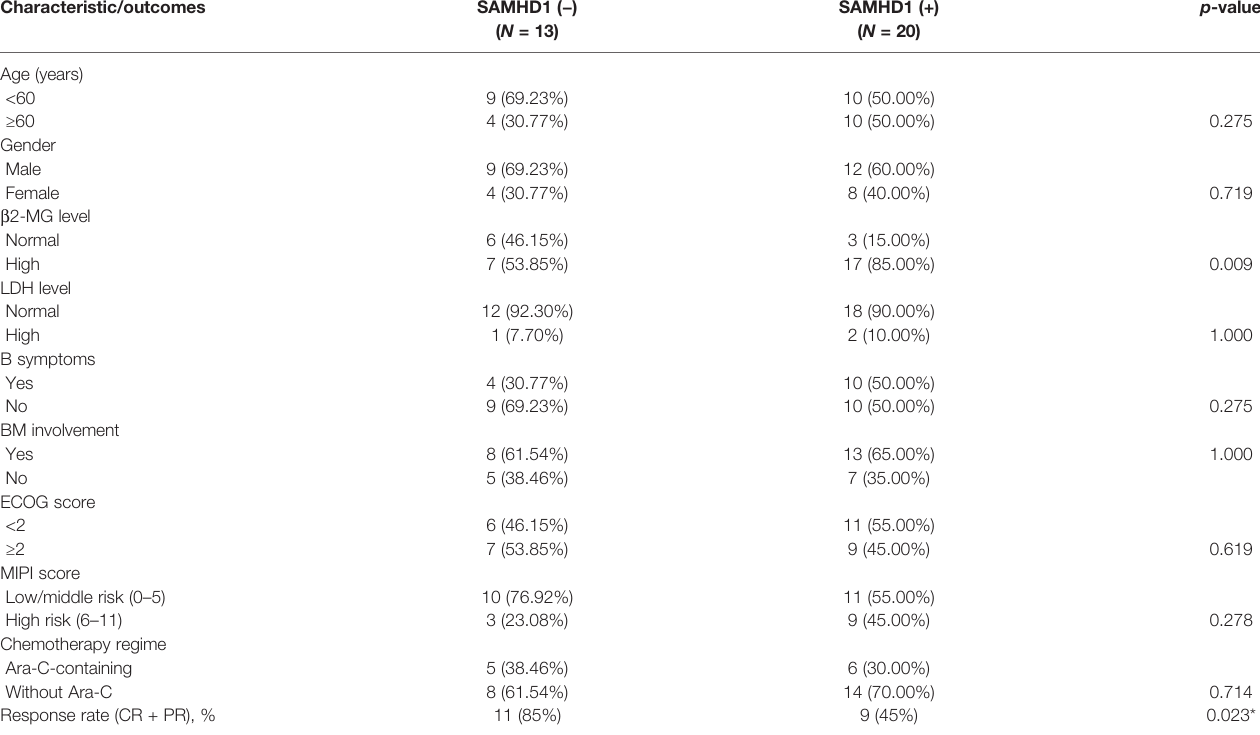
TABLE 2 | Clinical characteristics and SAMHD1 expression in 33 cases of MCL with chemotherapy a .